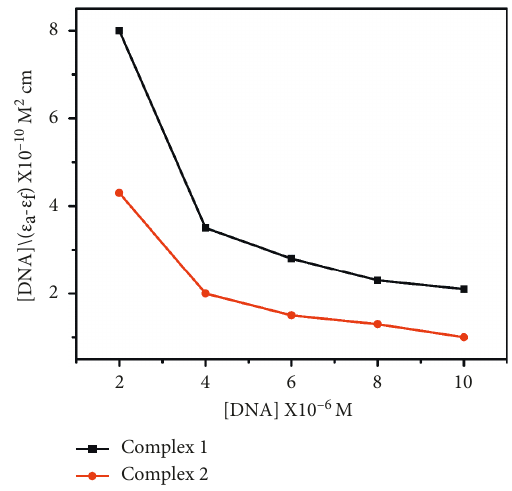
Figure 4: Plots of (DNA)/( εa − εf ) vs. (DNA).